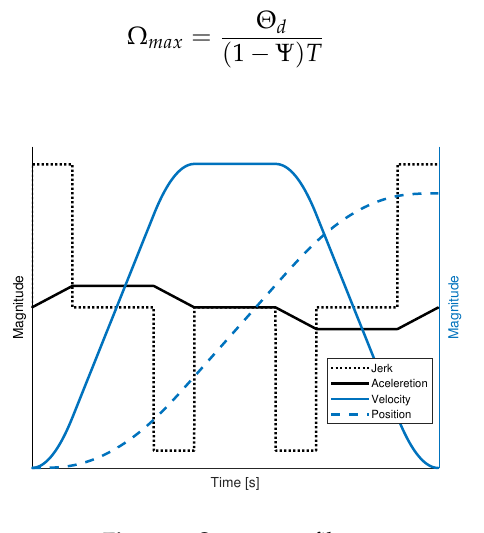
Figure 2. S-curve